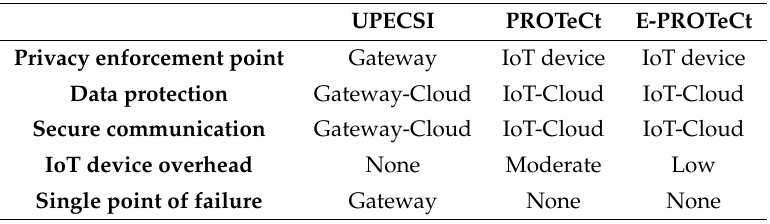
Table 1. Comparison among the